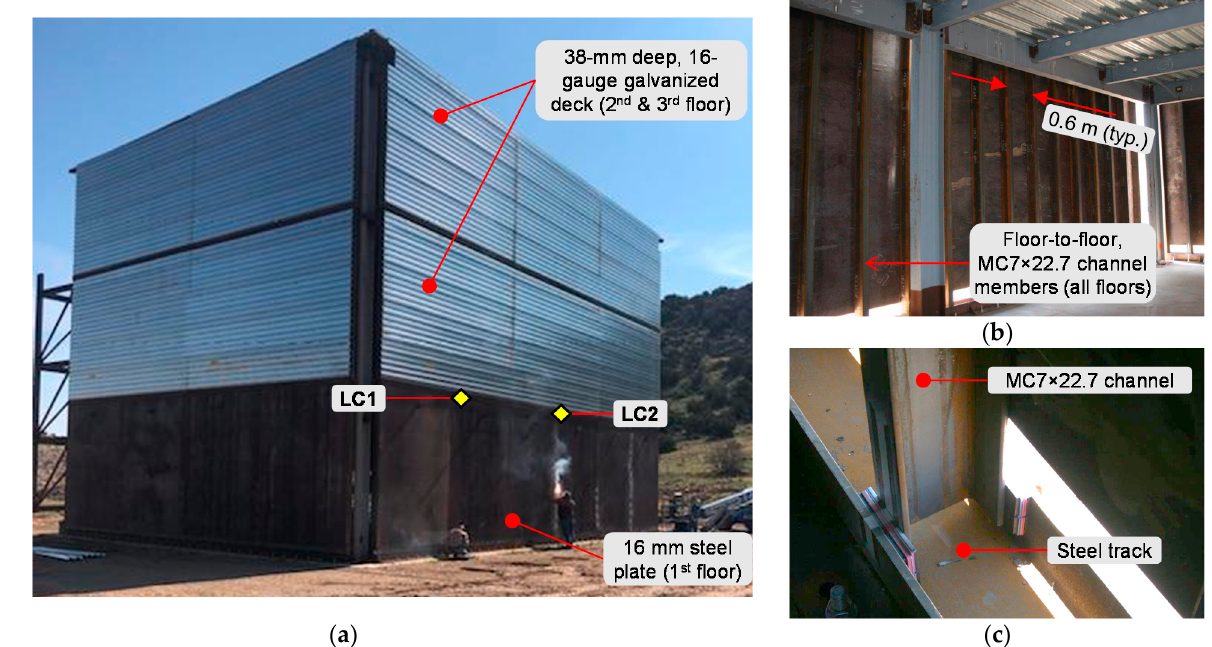
Figure 5. View of the test structure with blast ‐ resistant steel façade for Test 2: ( a ) Southwest elevation view (LC = load cell, refer to Figure 9b); ( b ) View from the inside on the 1st floor (same channel configuration on all floors); ( c ) Close ‐ up view of bottom end connection of MC7 × 22.7 façade channels to allow sliding for in ‐ plane motion and resist load for out ‐ of ‐ plane motion.